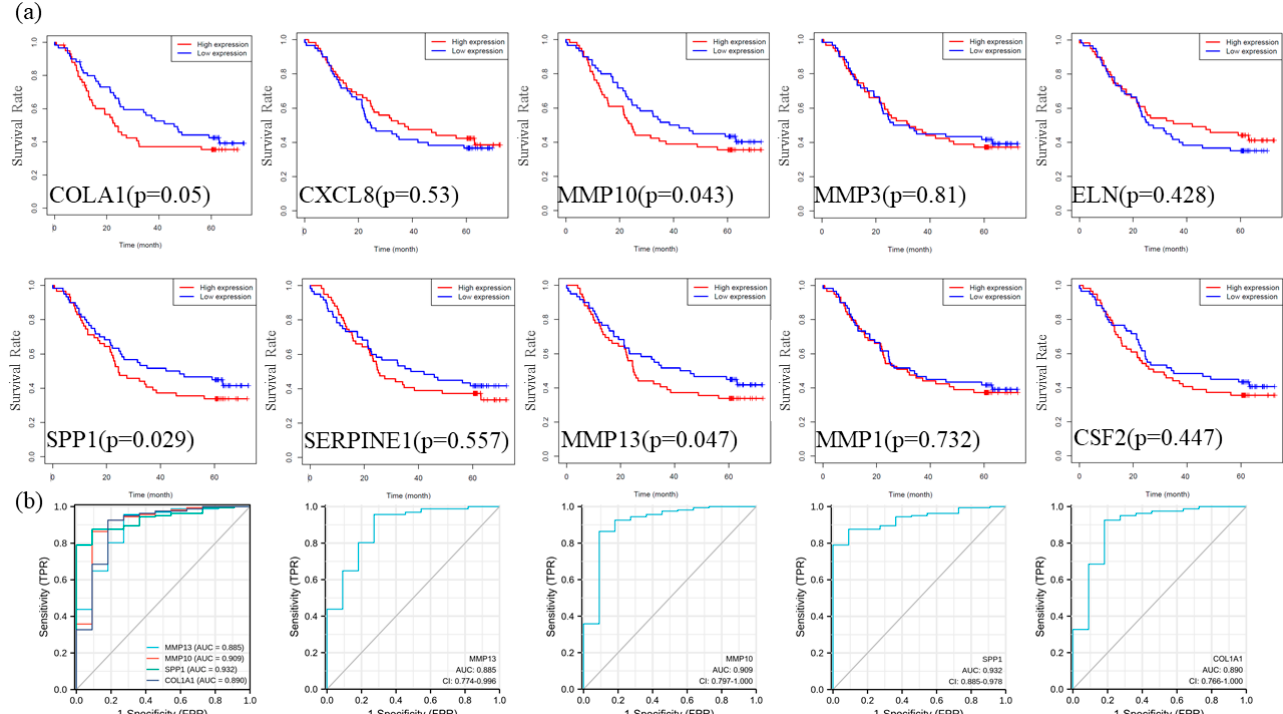
Figure 7. Survival analysis and ROC curve for overall survival in ESCC. ( a ) Survival analysis of ten differential expression genes ( p < 0.05 for prognostic significance); ( b ) ROC analysis of the four genes that were significant in survival analysis (area > 0.9 under the curve is of high diagnostic value).